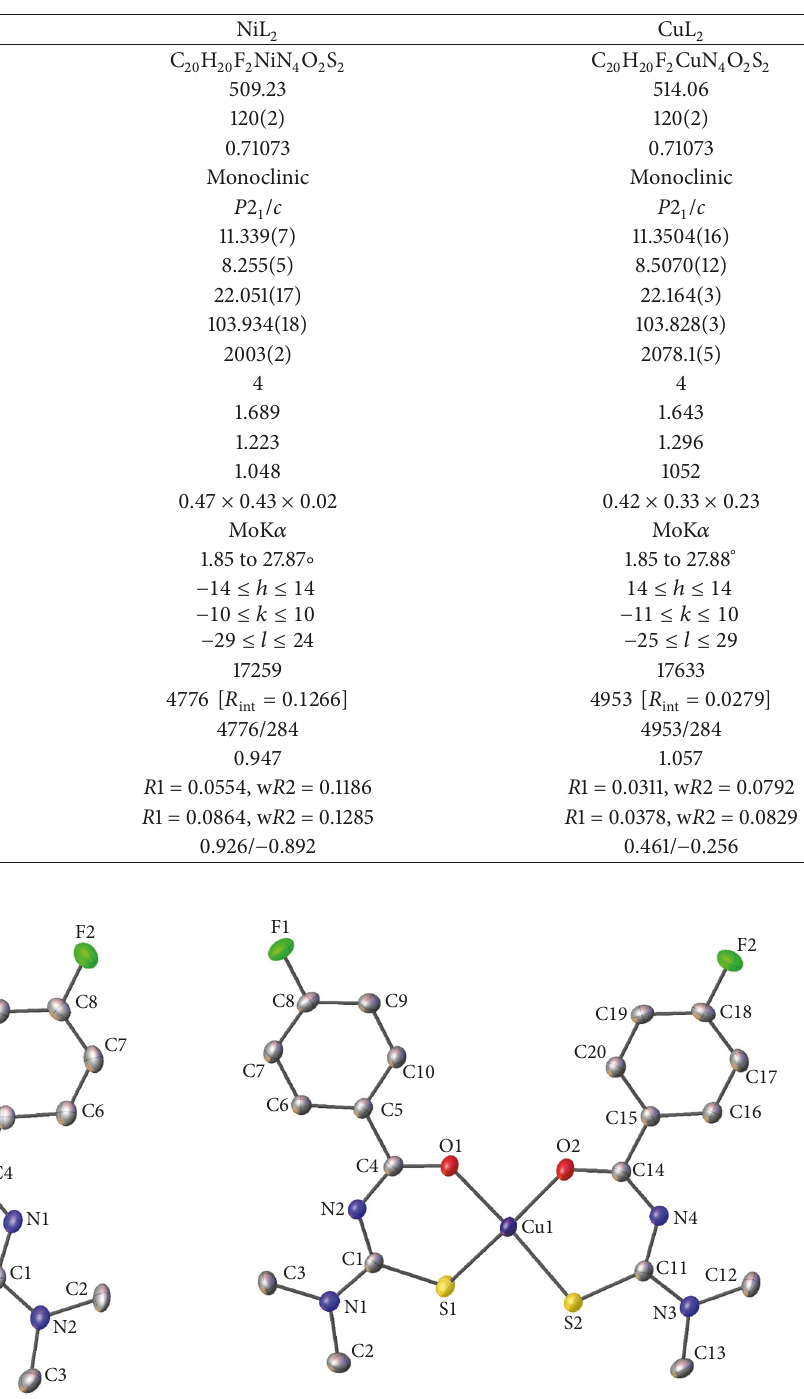
Table 1: Crystal data and structure refinement for NiL 2 and CuL 2 complexes.